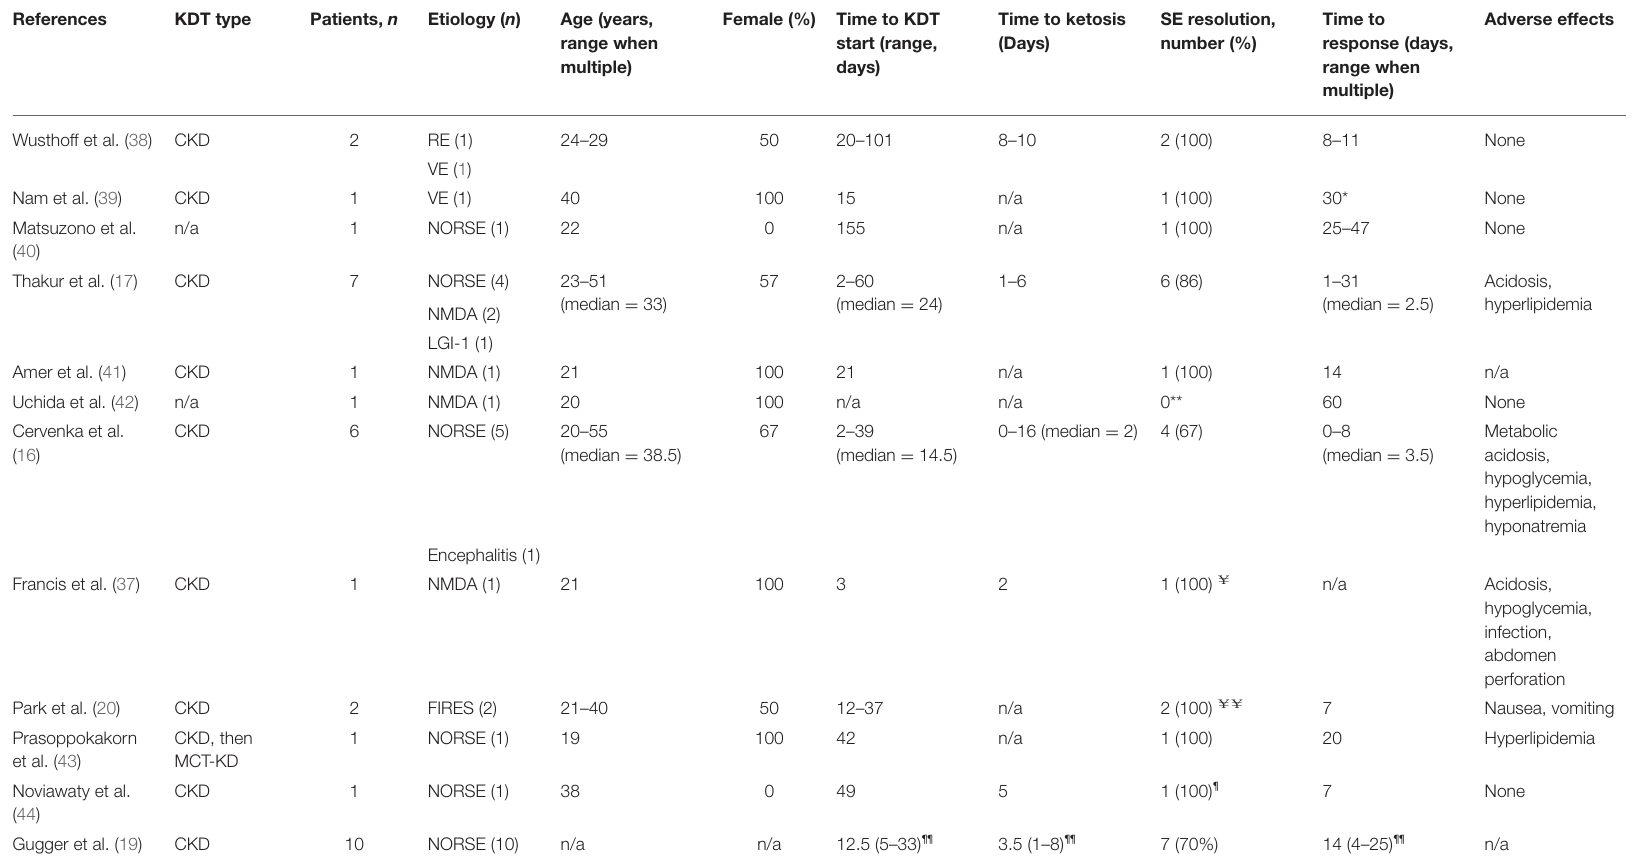
TABLE 3 | Summary of published adult patients with RSE due to presumed infectious and immune-mediated etiologies treated with adjunctive